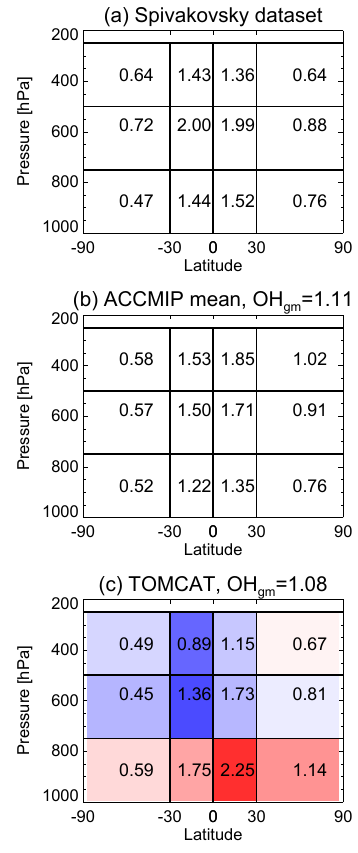
Figure 4. Regional annual mean OH concentrations ( × 10 6 moleculescm − 3 ) split into subsections as recommended by Lawrence et al. (2001). (a) OH estimated from methyl chloroform observations from Spivakovsky et al. (2000), (b) the Atmospheric Chemistry and Climate Model Intercomparison Project (ACCMIP) multi-model mean simulated OH concentrations from Naik et al. (2013) and (c) TOMCAT-simulated OH concentrations for the year 2008. The air-mass-weighted global mean tropospheric OH (OH gm ) is indicated above each plot for panels (b) and (c) . In TOMCAT, the troposphere was defined as the area below a climatological tropopause ( p = 300 − 215 ( cos ( lat )) 2 ) (as discussed in Lawrence et al. (2001)) and for ACCMIP it was defined as below 200hPa. The colours in panel ( c ) are scaled according to the difference from panel (a) , with the darkest blue representing the largest negative differences and the darkest red representing the largest positive